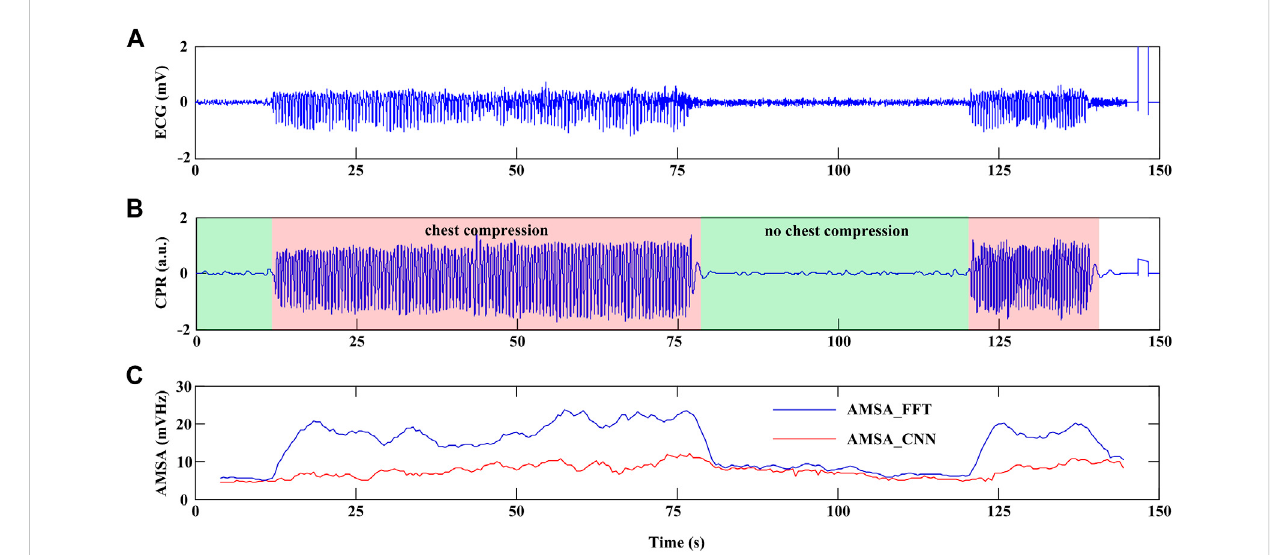
FIGURE 7 Example of continuous AMSA monitoring during CPR. (A) ECG waveform. (B) CPR reference signal. (C) AMSA_FFT and AMSA_CNN values.